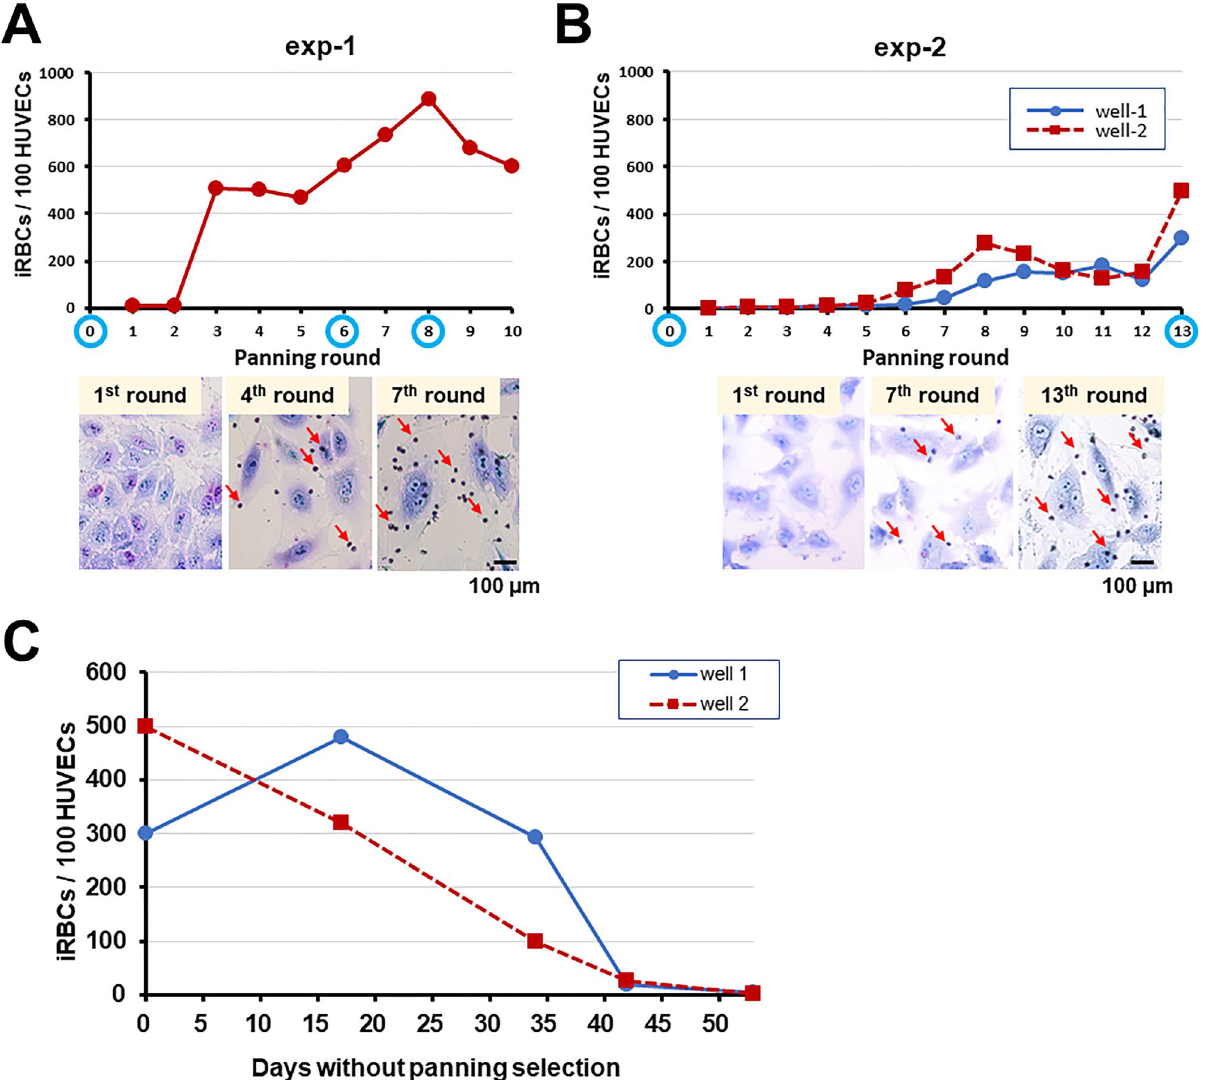
Figure 1. Panning selection of P. knowlesi -iRBCs against HUVECs. ( A ) First panning selection experiment (exp-1). RNA samples were obtained before and after the 6th and 8th pans (blue circle on the x-axis). Images after the 1st, 4th, and 7th rounds are shown below. ( B ) Second panning selection experiment (exp-2). Two wells (well-1 and well-2) were simultaneously panned 13 times and RNA samples are collected before and after the 13th pan (blue circle on the x-axis). Images after the 1st, 7th, and 13th rounds are shown below. ( C ) Binding activity of iRBCs in 2 wells at 17, 34, 42, and 53 days after the 13th pan of exp-2 without panning selection